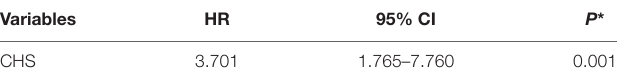
TABLE 5 | Cox survival analysis results in MSA patients at the disease duration ≤ 3